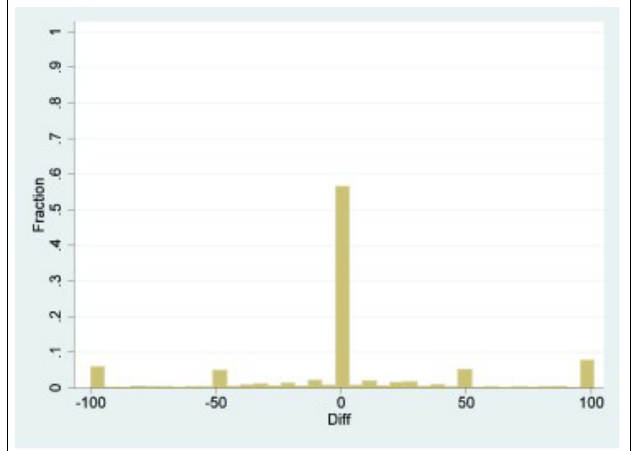
Figure 1. Distribution of the changes in X -balls choices in two successive